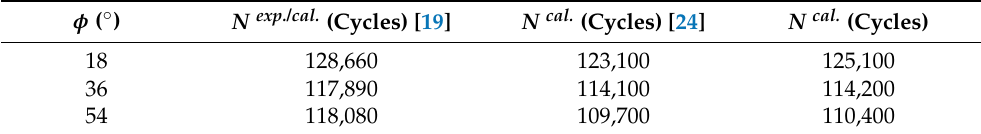
Table 2. Evaluated number of loading cycles and loading angles for relevant mixed mode